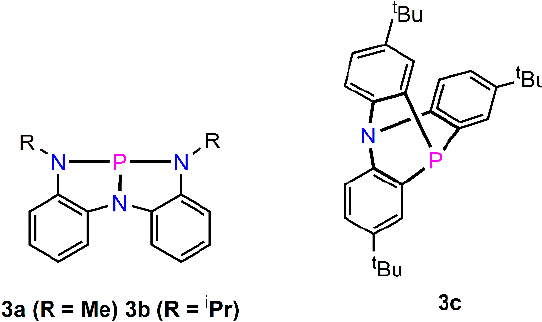
Figure 5. Selected examples of cyclic P,N-ligands.